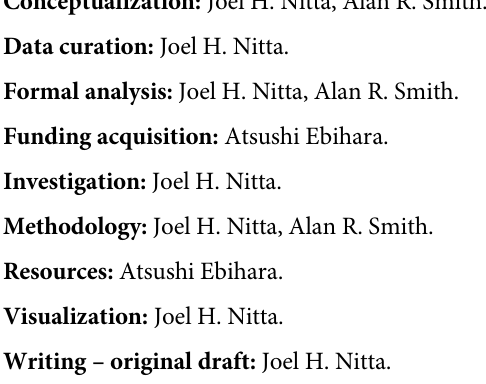
S2 Table. A checklist of ferns and lycophytes observed at the Nectandra Cloud Forest Reserve, Costa Rica. All voucher specimens deposited in UC with duplicates when available at CR, GH, and TI. For additional data on each voucher specimen, see Dryad repository [51].